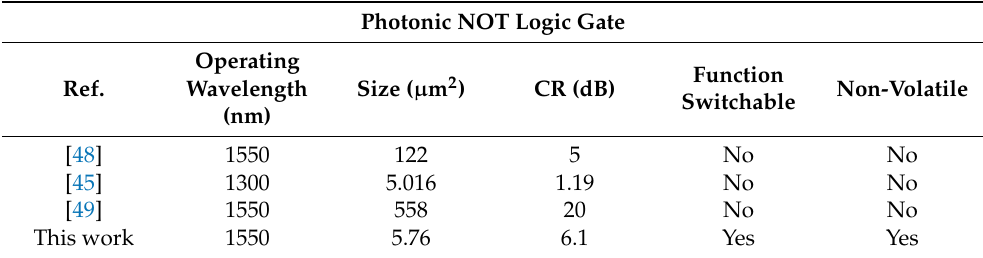
Table 4. Performance comparison between the proposed photonic NOT logic gate and several reference structures reported in other